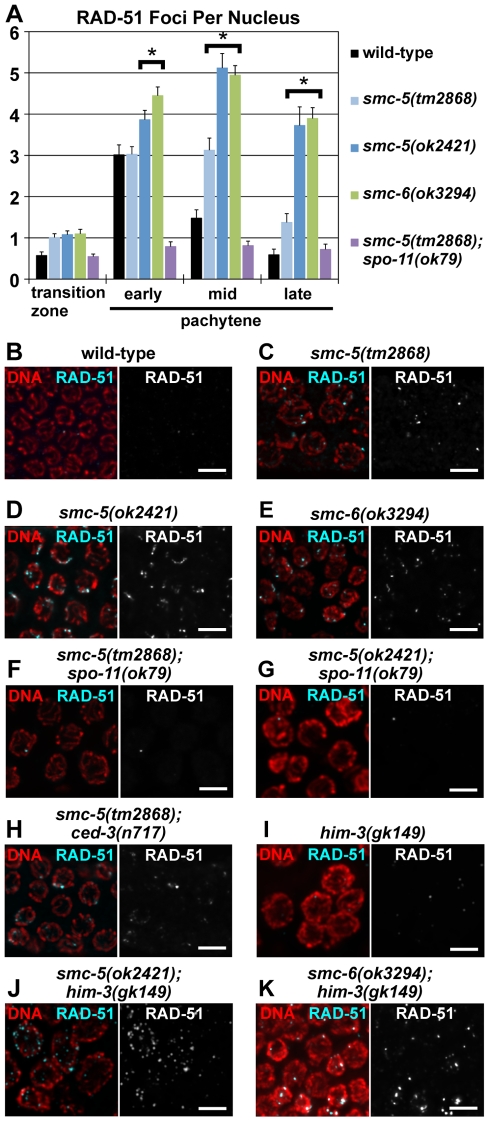
Aberrant RAD-51 accumulation in meiotic germ cells from the smc-5 and smc-6 mutants.(A) The average numbers of RAD-51 foci per nucleus in the transition zone and pachytene regions of the gonad arms are represented in the bar graph; the error bars represent standard errors. The pachytene region was divided into three equal length areas (early, mid and late) and each quantified separately. The smc-5 and smc-6 mutants showed significant increases in RAD-51 foci in comparison to wild-type at the mid- to late-pachytene regions (p≤0.01; two-tailed t-Test). The numerical values and sample sizes are summarized in Table S3. (B–K) Micrographs of RAD-51 immunofluorescence and DAPI-DNA fluorescence in late pachytene nuclei from the wild-type and the mutant germlines. Scale bars = 5 µm.